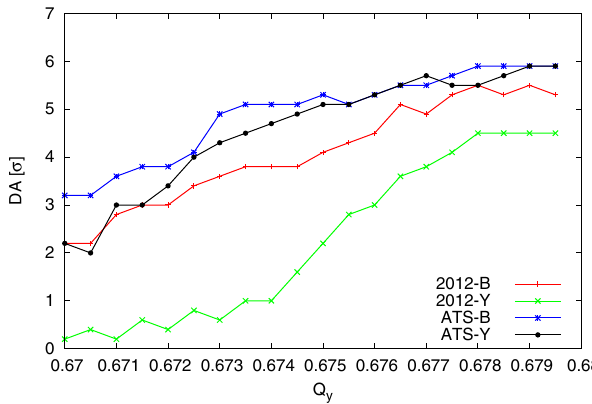
FIG. 8. Simulated dynamic aperture as a function of the vertical tune Q without beam-beam interactions. B denotes the Blue, and y Y the Yellow ring.